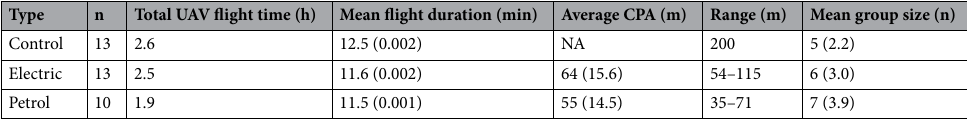
Table 3. Summary of controlled exposure experimental focal follows with an unmanned aerial vehicle (UAV) with mean flight times and standard deviations (in brackets). The closest point of approach (CPA) of the whale-watch vessel is listed, and the minimum and maximum range to the animals, along with the mean group size of pilot